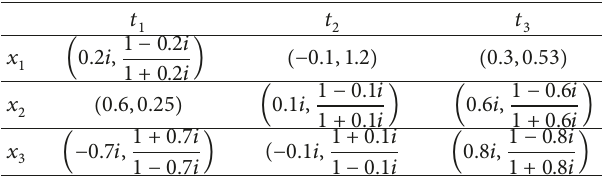
Table 13: TCIFS A 1 .